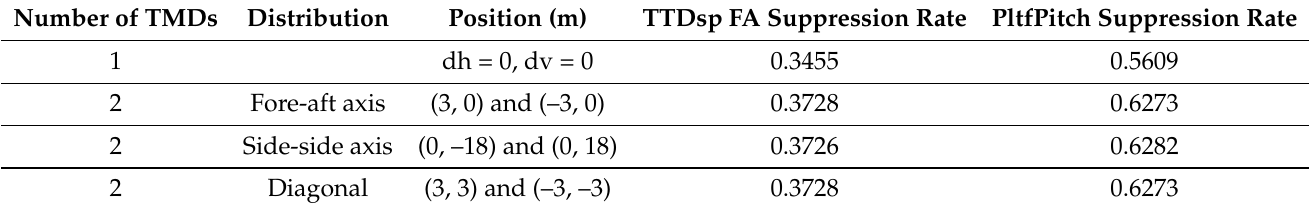
Table 3. Comparison of different positioning of the TMDs and the suppression rate of TTDspFA and of PltfPitch. Number of